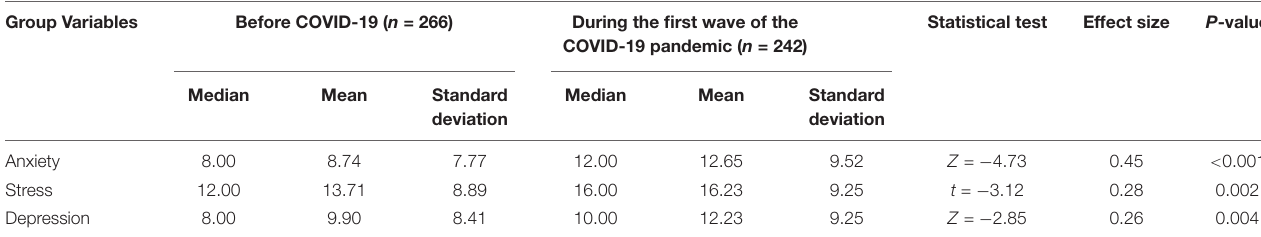
TABLE 3 | Comparison of the anxiety, stress, and depression scores among nurses before and during the first wave of the COVID-19 pandemic. Group Variables Before COVID-19 ( n = 266) During the first wave of the Statistical test Effect size P -value COVID-19 pandemic ( n = 242) Median Mean Standard Median Mean Standard deviation deviation Anxiety 8.00 Stress